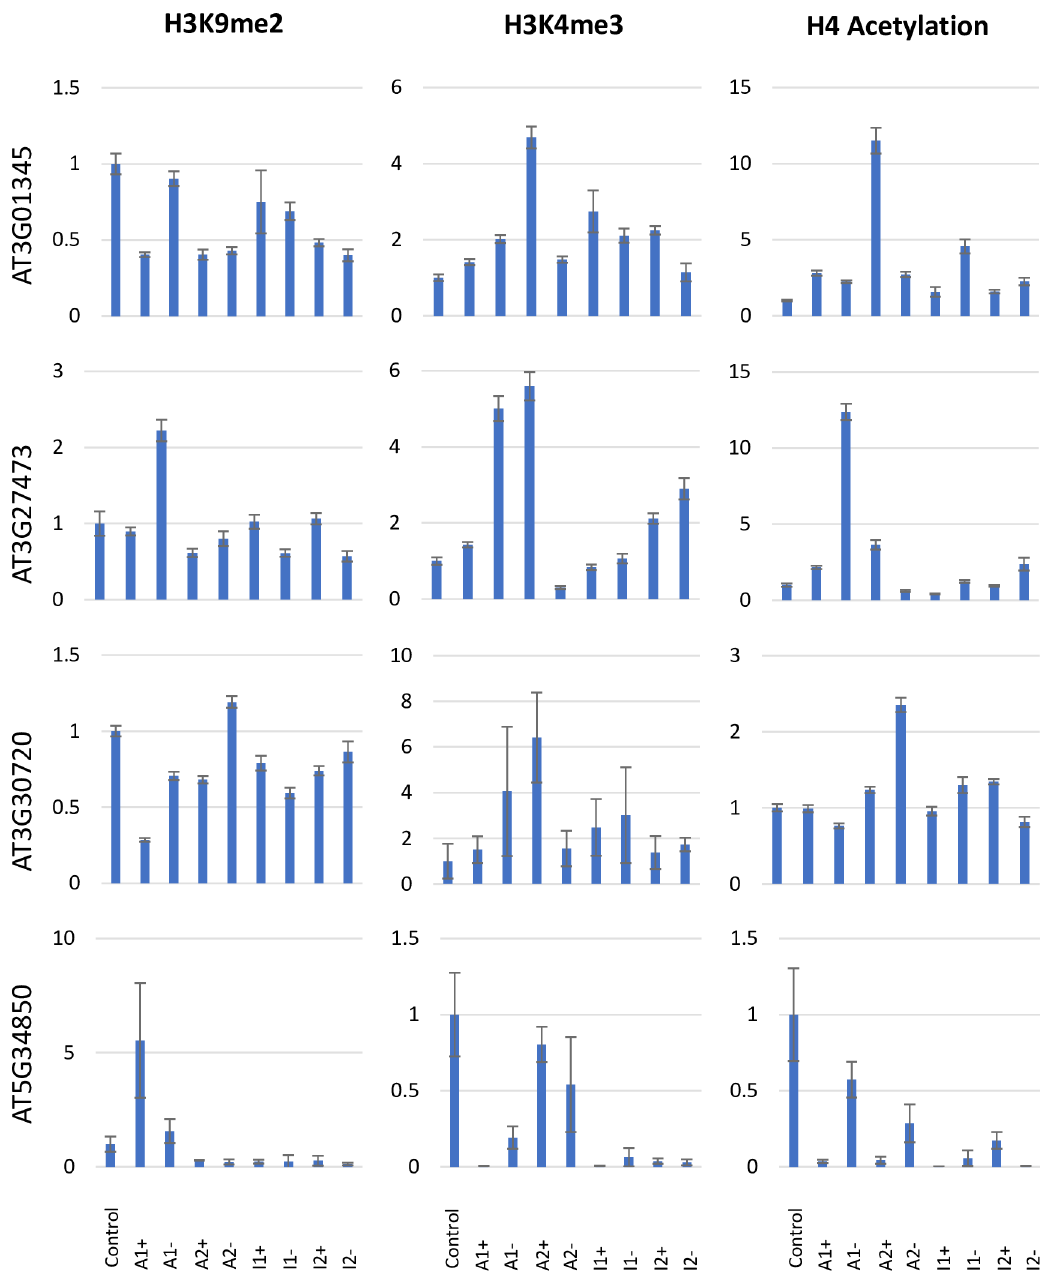
Fig 4. ChIP analysis of genes At3G27473 , At3G01345 , At3G30720 and At5G34850 for H3K9me2, H3K4me3 and H4 acetylation marks. The means and the standard errors are shown for three biological replicates each tested in three technical replicates. Values on the y-axis represent the fold-difference of histone mark levels compared to the control line.